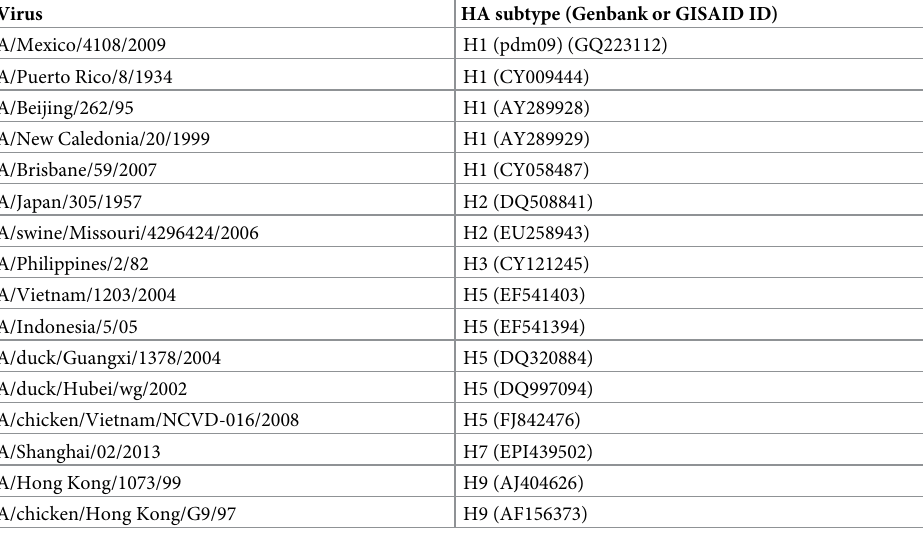
Table 1. HA gene list.